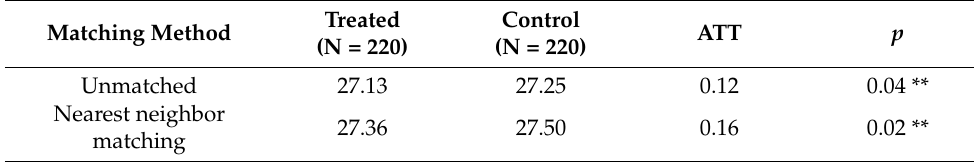
Table 9. Propensity score match estimation